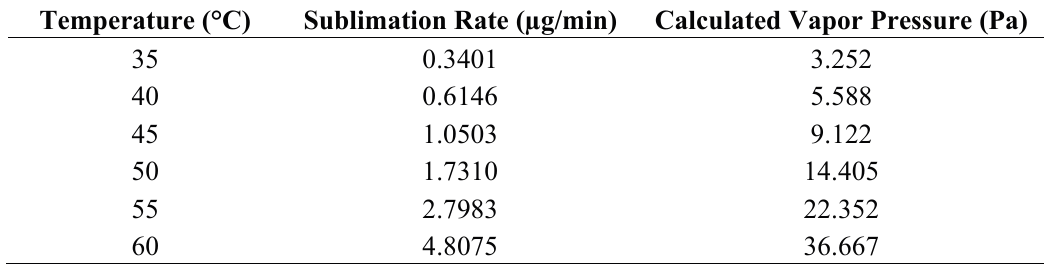
Figure 6. Linear relationship between the ln (sublimation rate) and ln (vapor pressure) of benzoic acid (reported in the literature). Table 3. Sublimation rate and calculated vapor pressure for